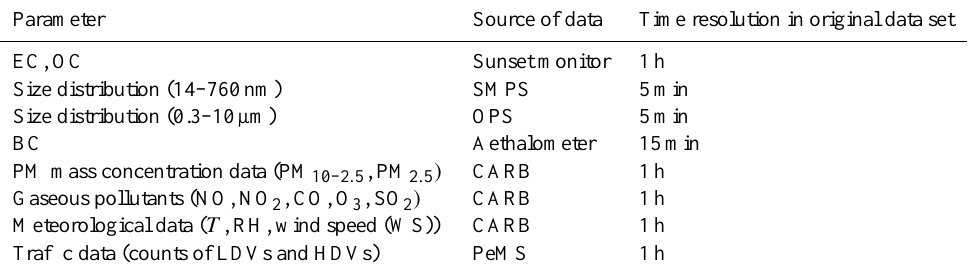
Table 1. Summary of the input parameters to the PMF model in this study. Parameter Source of data Time resolution in original data set EC, OC Sunset monitor 1h Size distribution (14–760nm) SMPS 5min Size distribution (0.3–10µm) OPS 5min BC Aethalometer 15min PM mass concentration data (PM 10–2 . 5 , PM 2 . 5 ) CARB 1h Gaseous pollutants (NO, NO 2 , CO, O 3 , SO 2 ) CARB 1h Meteorological data ( T , RH, wind speed (WS)) CARB 1h Traffic data (counts of LDVs and HDVs) PeMS